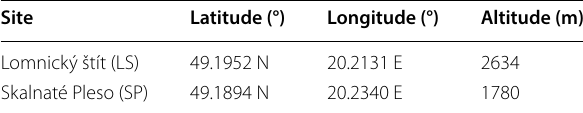
Table 1 Geographical coordinates of measuring sites